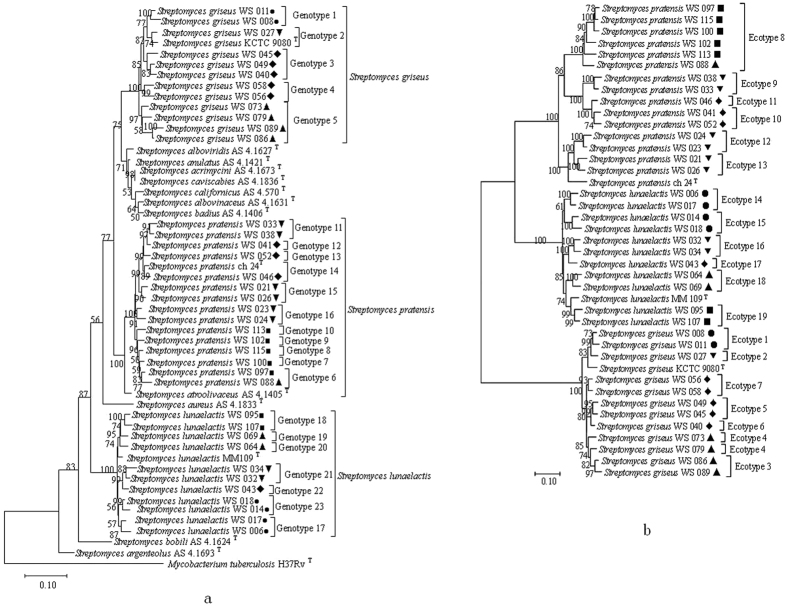
Maximum Likelihood based Phylogenetic trees of concatenated sequences of four house-keeping genes (indicated by A, 16S rRNA, rpoB, recA and atpD) and salty-tolerented related genes (indicated by B, ectA-D), showing endemism for three Streptomyces OTUs.Bar, 0.1, ten nucleotide substitutions per 1000 nt; Bootstrap values are shown as percentage of 1000 replicates, and only the bootstrap values above 50% are shown. Solid squares (■) and pright triangles (▲) denote Qijiaojing (QJJ) and Aydingkol (AK) salt lake sites in Xinjiang Province; inverse triangles (▼), diamonds (♦) and black circles (•) denote Jiangcheng (JC), Heijing (HJ), Yunlong(YL) salt mine sites in Yunnan Province, respectively. The geno- and ecotype STs are marked in the clades, and each genotype is supported by high bootstrap value (>80%).